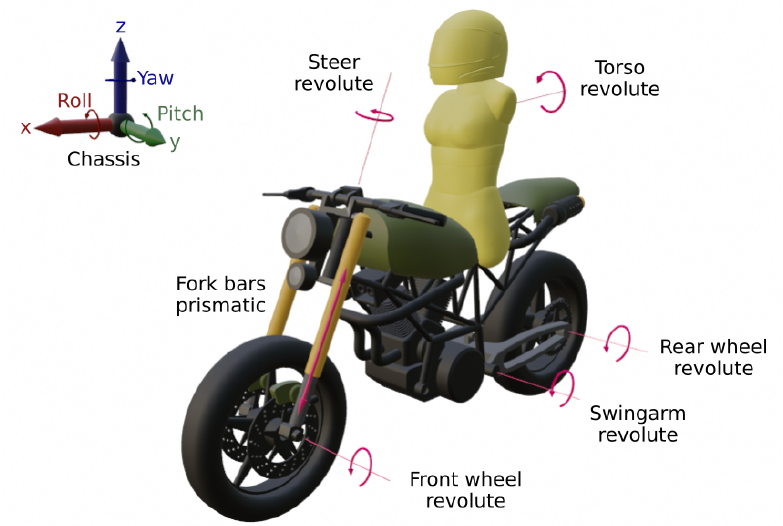
Figure 1. Multibody model elements and DOFs.